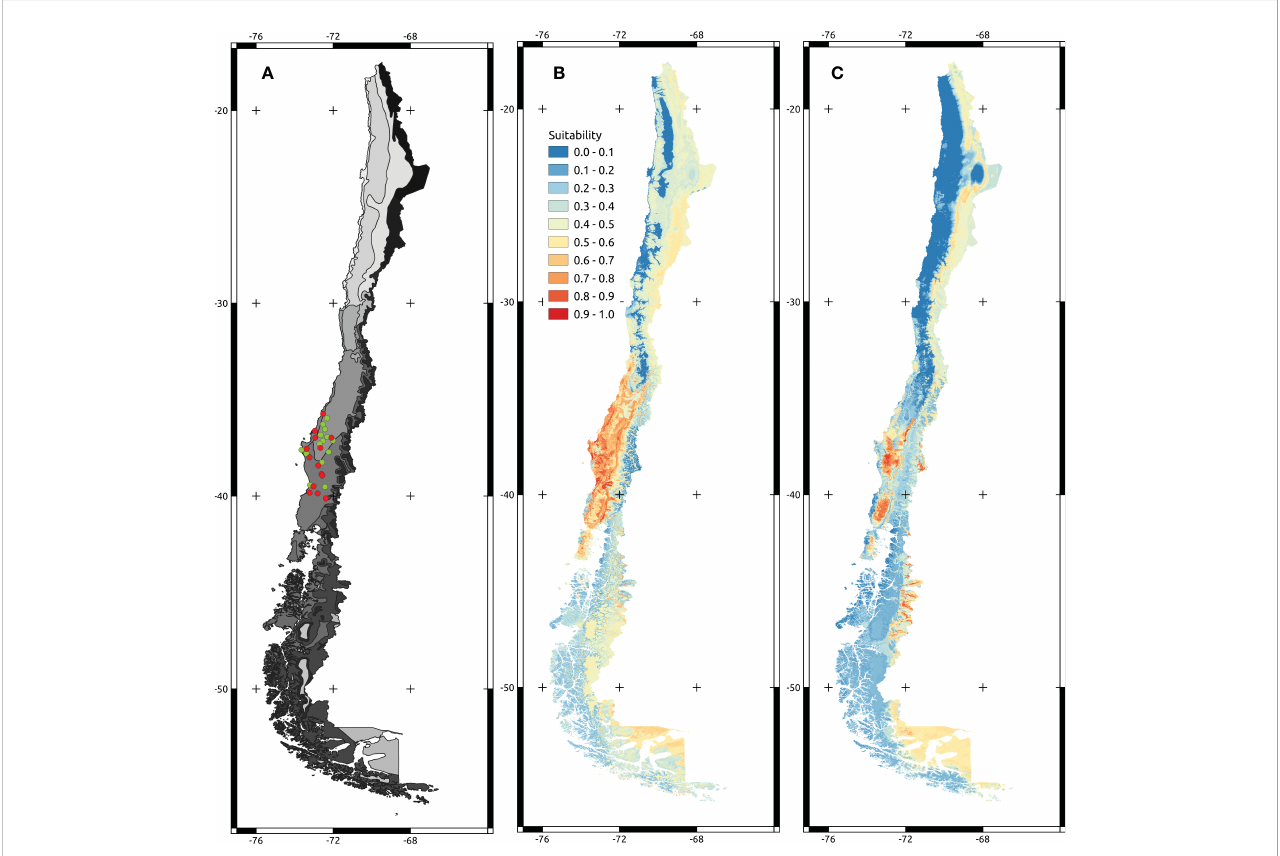
FIGURE 1 Maps showing localities of the trials and projected models. (A) Map of climatic zones in Chile. Grey scale ranges from desertic environments (lighter grey) to tundra (darker grey). Green points correspond to the A dealbata trial localities. Red points correspond to the A melanoxylon trial localities. (B, C) correspond to A melanoxylon and A dealbata projected models over continental Chilean